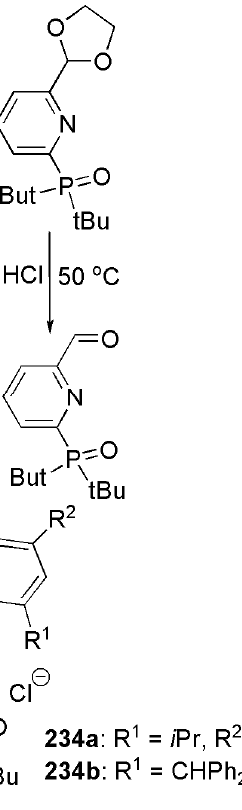
Scheme 56. Synthetic strategy for bidentate NHC ‐ PR 2 (O) ligands [208].